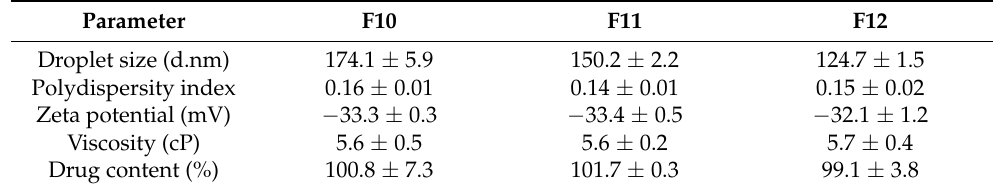
Table 3. Effect of Tween ® 80 concentration on droplet size, polydispersity index, zeta potential, and drug content of moxifloxacin-containing NE formulations (mean ± SD, n = 3). Parameter F10 F11 F12 Droplet size